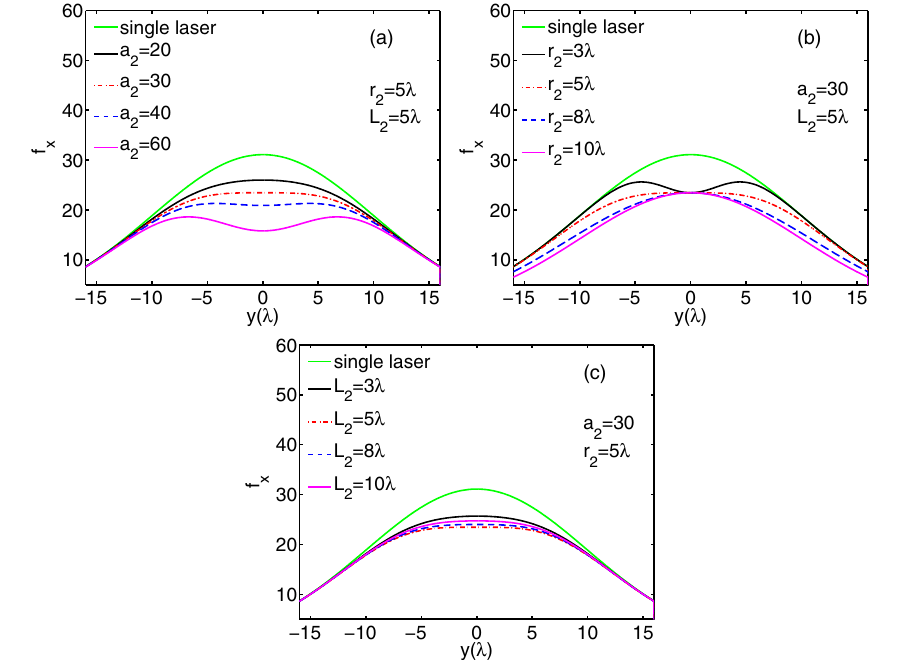
FIG. 2. The transverse distributions of the longitudinal component ( x ) of the resultant ponderomotive force for different intensities (a), waist radiuses (b), and pulse widths (c) of the auxiliary laser. For the main laser pulse, normalized amplitude a 1 ¼ 120 , waist radiuses r 10 λ , and pulse width L 8 λ 1 ¼ 1 ¼